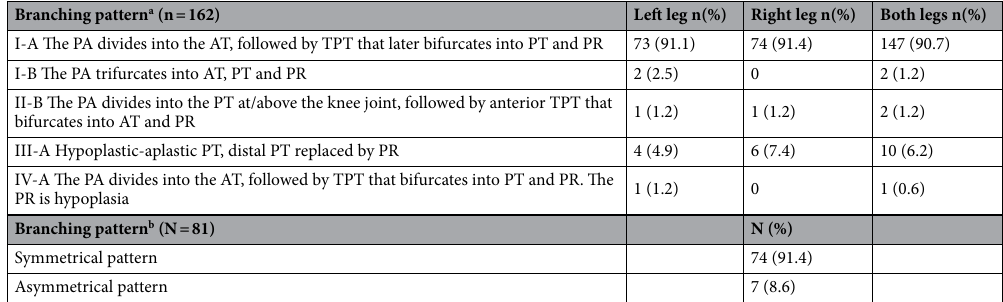
Table 2. Variation of popliteal artery branching in lower extremities found in this study. PA popliteal artery, AT anterior tibial artery, PT posterior tibial artery, PR peroneal artery, TPT tibioperoneal trunk. a The classification follows Kim et al. and Abou-Foul et al. Other types which are not shown in the table are not found in this study. b Comparing with contralateral leg, symmetrical pattern of both common pattern and symmetrical variants are included. In terms of the asymmetrical pattern, another limb reveals common pattern in all cases.